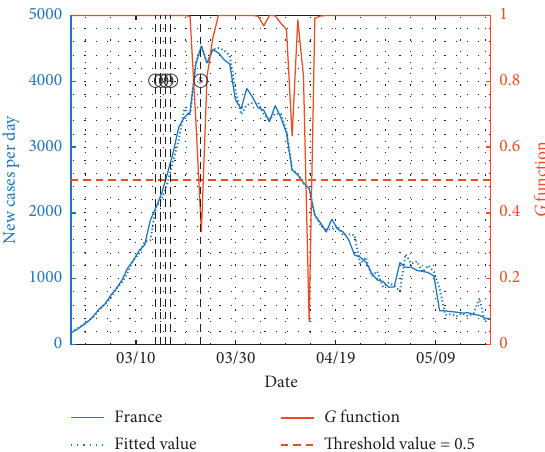
Figure 9: The fitting result of Spain. The left axis shows the daily confirmed cases for the real data after smoothness (blue solid line) and its fitted values by the STAR model (blue dashed line). The right axis shows the value of nonlinear functions G changing with time (orange solid line) and the reference line with threshold 0.5 (orange dashed line). The vertical dotted line indicates the se- quential released policies: ① restrict free traveling for 15 days, ② isolate residents at home and close nonessential places, ③ trans- form Madrid’s convention and exhibition center into a “makeshift hospital,” ④ force workers in noncore industries to stay at home, and ⑤ upgrade epidemic prevention and control measures.